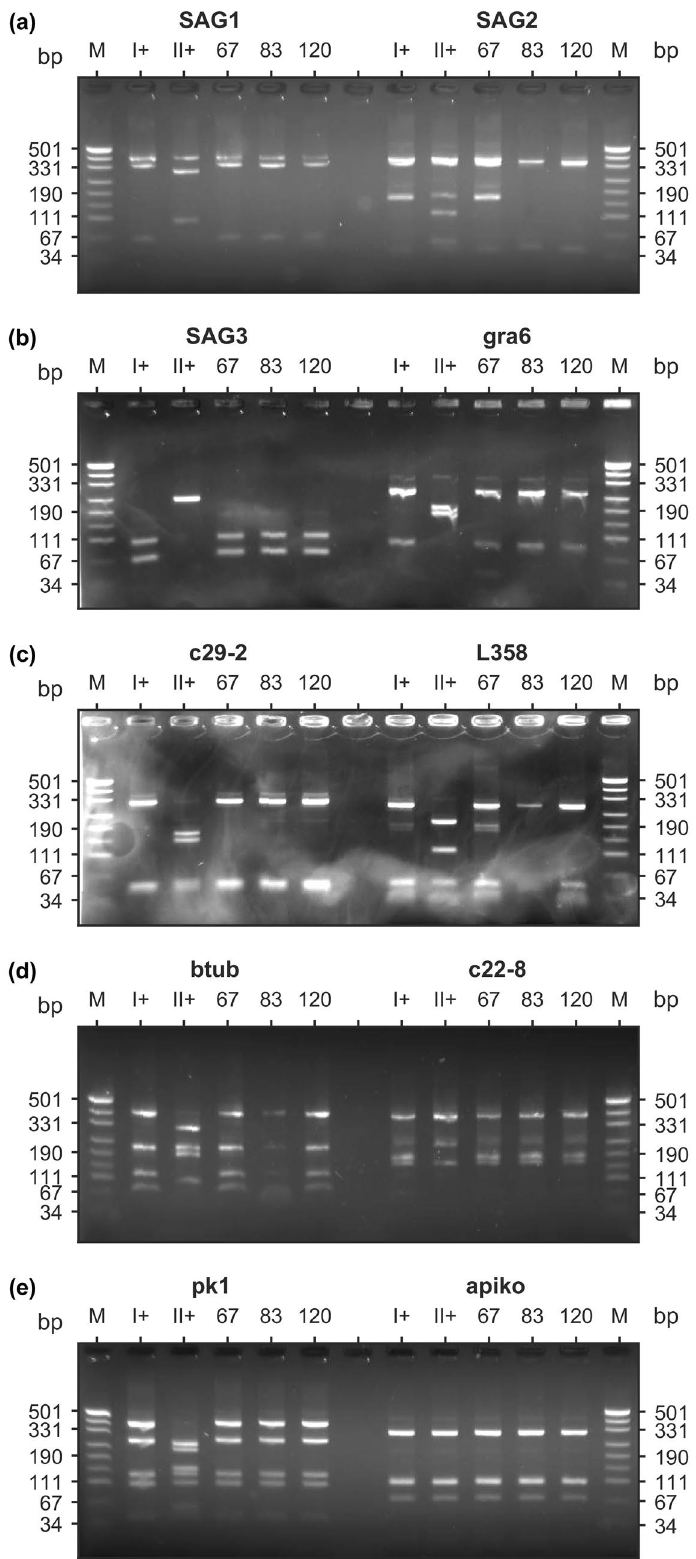
Figure 2. Results of multiplex multilocus nested PCR-RFLP (Mn-PCR-RFLP) analysis of Toxoplasma gondii samples using 10 different genetic markers. M (pUC19 DNA/MspI (HpaII) Marker, Thermo Fisher Scientific) – molecular weight marker, I+ – T. gondii type I positive control, II+ – T. gondii type II positive control, 67 – positive wastewater sample (template No. 67), 83 – positive wastewater sample (template No. 83), 120 – positive wastewater sample (template No. 120). The samples derive from the same experiment and gels were processed in parallel. The gels were properly cropped to improve the clarity and conciseness of the presentation; the full-length gels are presented in Supplementary Fig. S2–S5. Figure was prepared using MATLAB